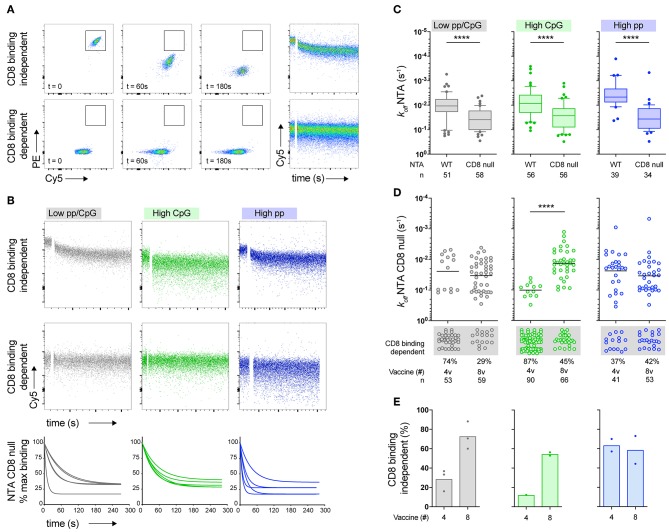
Contribution of CD8 binding to TCR/CD8-pMHC dissociation rates (koff) of Melan-A-specific CD8 T-cell clones. (A) Representative FACS-based staining dot plots at different time-points and dissociation curves from two tumor antigen-specific CD8 T-cell clones obtained after labeling with CD8 binding-deficient NTAmers. Imidazole was added after 25 s of baseline recording. The upper panels represent a T-cell clone capable to bind to CD8-null NTAmers (defined as CD8 binding-independent) with monomeric TCR-pMHC dissociation followed in the Cy5 channel during 270 s. The lower panels represent a T-cell clone that is unable to bind to CD8-null NTAmers (defined as CD8 binding-dependent). (B) Representative FACS-based dissociation curves obtained from Melan-A-specific CD8 T-cell clones derived from patients vaccinated with either low peptide/CpG (gray), high CpG (green), or high peptide (blue) dose protocol. CD8 binding-independent (upper panels) and CD8 binding-dependent (low panels) tumor antigen-specific T-cell clones are depicted. CD8-null NTAmer-based dissociation curves for CD8 binding-independent clones are shown (n = 5 for each vaccine cohort). (C) Direct comparison of the dissociation rates (koff) between wild-type and CD8-null NTAmers for each vaccine cohort. Data are representative of pooled EM28pos tumor antigen-specific T-cell clones (n = 294) and are depicted as box (25th and 75th percentiles) and whisker (10th and 90th percentiles) with the middle line indicating the median. P-values by Wilcoxon matched-pairs signed rank test; ****P < 0.0001. (D) CD8-null NTAmer-based dissociation rates (koff) categorized according to the vaccination cohort and the number of vaccine injections (4v vs. 8v). CD8 binding-dependent Melan-A-specific EM28pos T-cell clones from which koff could not be accurately calculated are depicted below the graphs. Total number of clones n and P-values by Mann-Whitney U test are indicated; ****P < 0.0001. (E) Frequency of EM28pos tumor antigen-specific T-cell clones of low CD8 binding dependency (i.e., CD8 binding-independent) according to the vaccination cohort and the number of vaccine injections (4v vs. 8v).